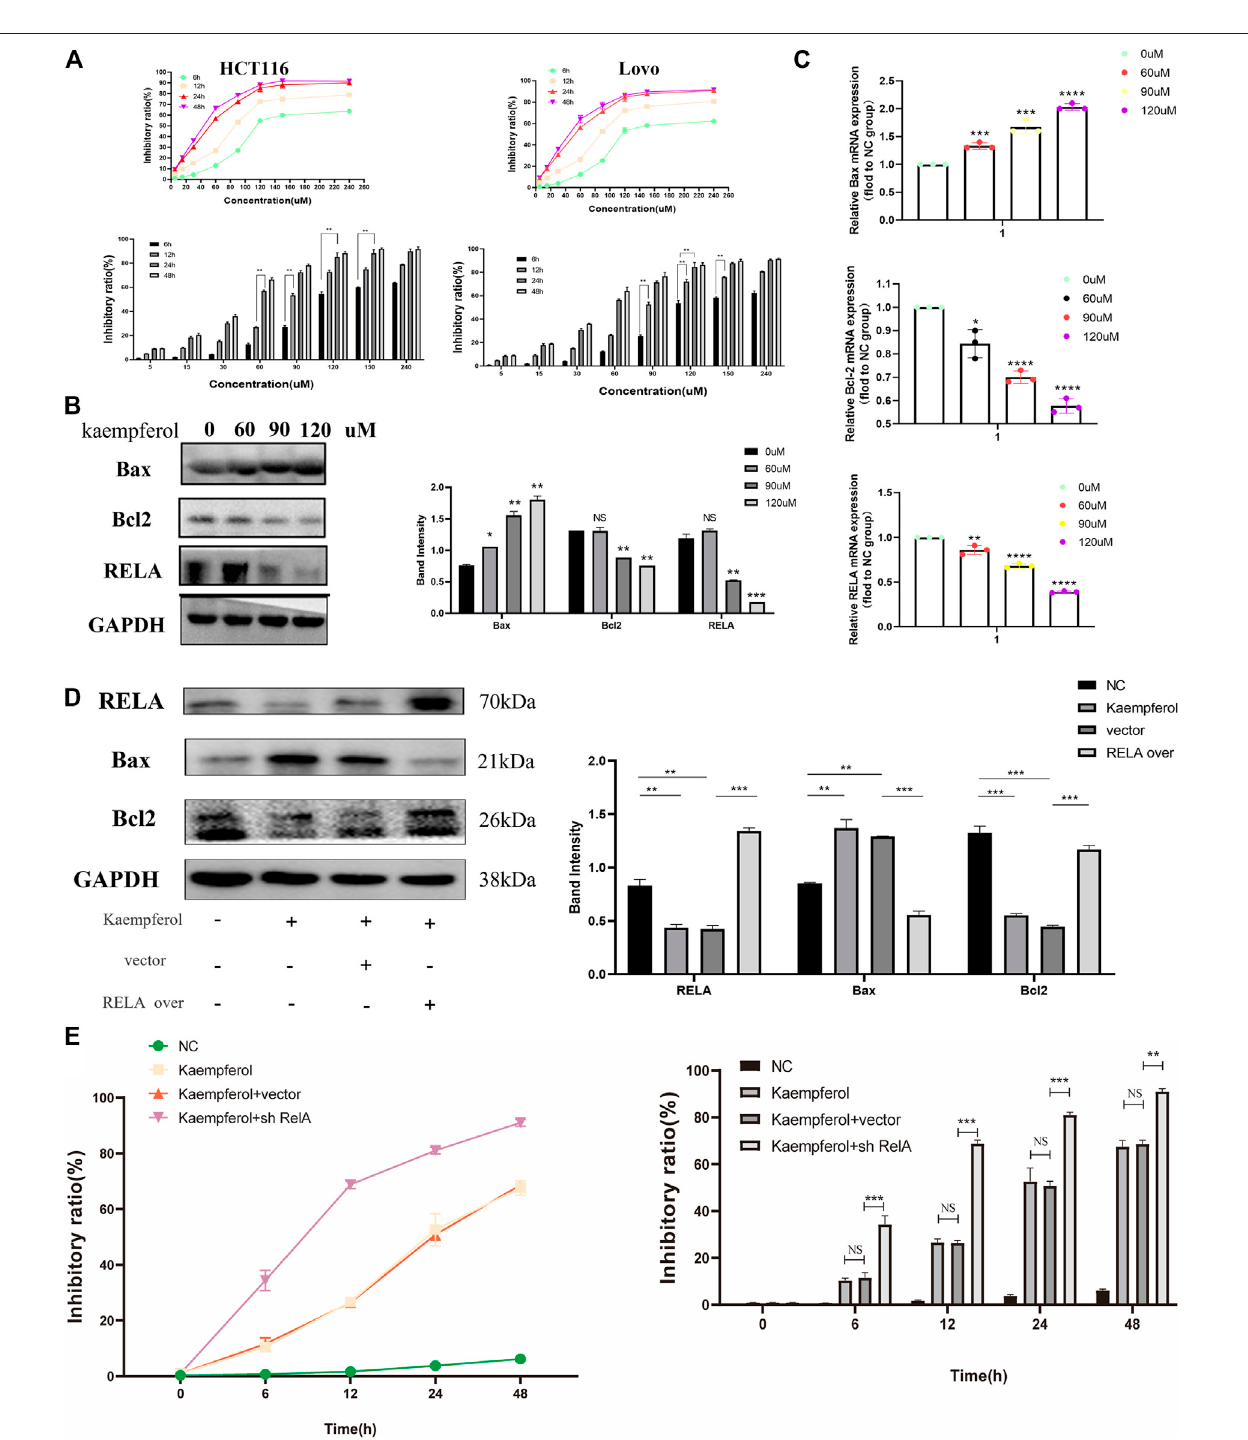
FIGURE9| Kaempferol,animportantactivecomponentin PM ,inhibitsthegrowthofcoloncancercellsbypromotingRELA-relatedapoptoticpathways. (A) CCK8 assayveri fi edtheeffectofkaempferolonHCT116andLovohumancoloncancercelllines.Eightconcentrationgradientsof5,15,30,60,90,120,150,and240 µMwere implemented, and the results showed that the inhibition rates of the two cell lines were similar. The cells were signi fi cantly inhibited at the concentrations of 60, 90, and 120 µM. (B) Westernblotassayand (C) qPCRassayveri fi edthatkaempferolregulatedtheexpressionofBax,Bcl2,andRELAinHCT116cellsatconcentrationsof 60, 90, and 120 µM, respectively. RELA was signi fi cantly inhibited with the increase of the concentration. Apoptosis was increased. (D) After overexpressed RELA plasmid and no-loaded plasmid were transfected, the effects of kaempferol on the expression of RELA, Bax, and Bcl2 in HCT116 cell lines were con fi rmed by Western blotting. (E) Aftersh-RELAplasmid and no-loaded plasmidweretransfected, theeffects ofkaempferolon thecellviabilityofHCT116 celllines werecon fi rmedbyCCK8. * p < 0.05 vs. negative control (NC) group, ** p < 0.02 vs. NC group, *** p < 0.01 vs. NC group, **** p < 0.001 vs. NC group.